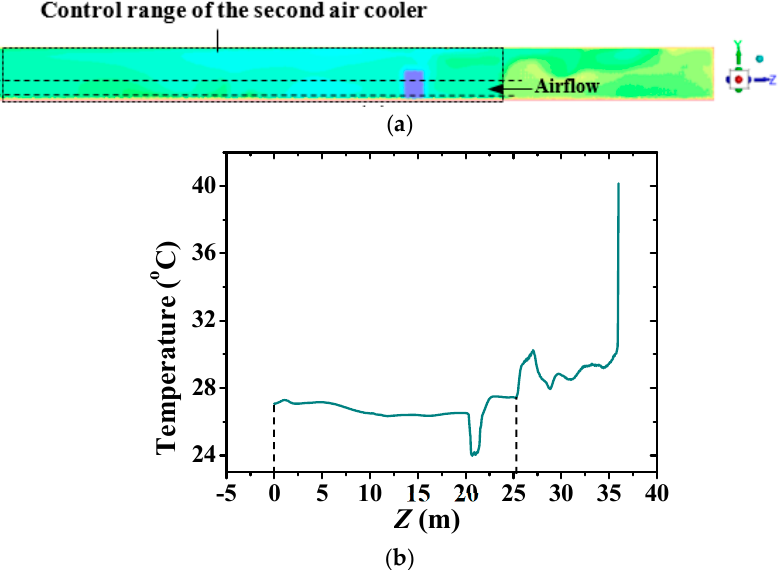
Figure 10. Temperature distribution of airflow in the cooling region for the heading face when the worker was located in the control range of the second tracking air cooler with exhaust ventilation: ( a ) temperature contour at the plane of X = 1.25 m; ( b ) variation of the temperature with the Z axis at the line of X = 1.25, Y = 1.5 m.